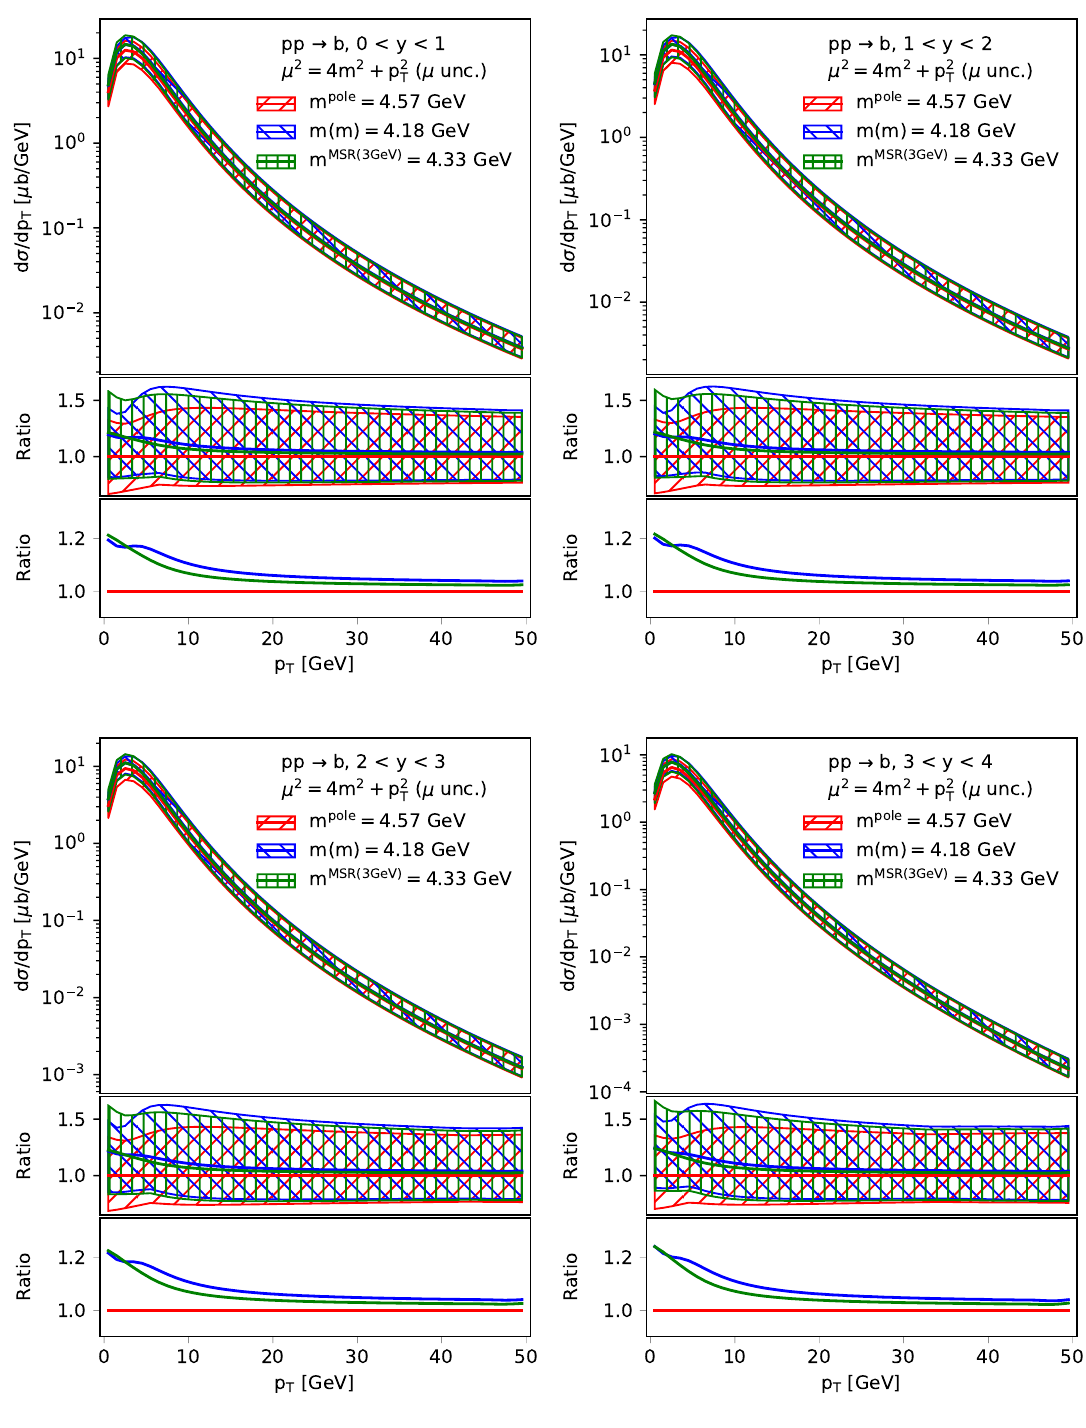
Figure 4 . Same as figure 2 for bottom